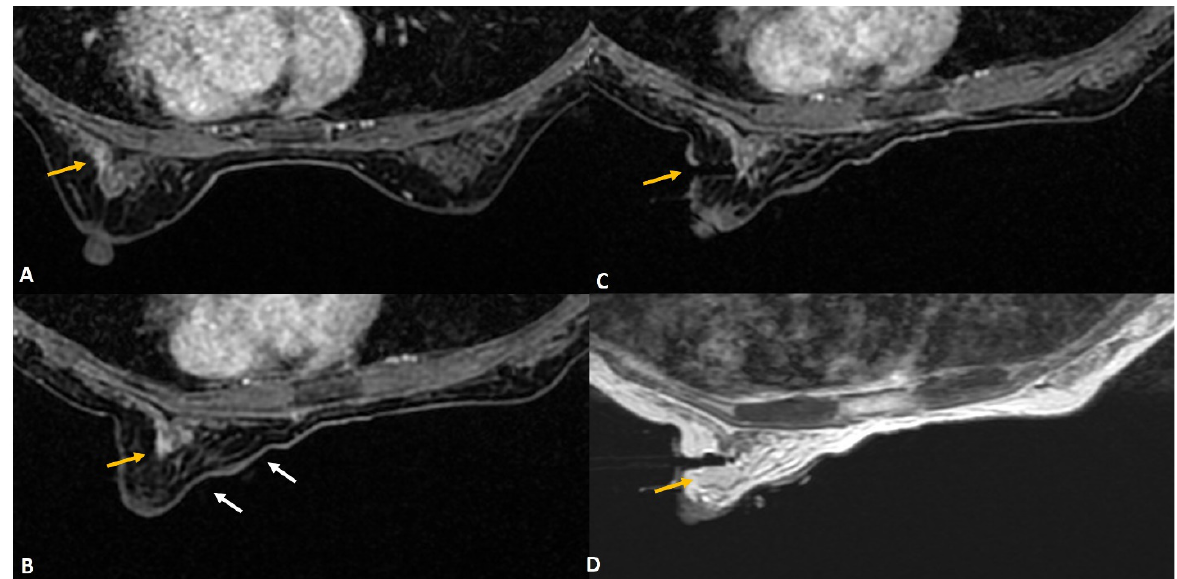
Figure 3. ( A ). MRI was performed in a woman with architectural distortion on mammogram de- tected during screening without sonographic correlate. A small enhancing correlate was identified on MRI (yellow arrow). ( B ). The breast size was extremely small. After removing the padding from the breast coil, the patient was tilted to obtain the target site in the grid hole. Additional padding was applied on the medial aspect (white arrows) to obtain optimal breast thickness making the procedure feasible and the target lesion (yellow arrow) accessible. ( C ). Tip of the obturator was noted at the target site (yellow arrow) and biopsy was performed using blunt tip Petit needle. ( D ). Post-biopsy hematoma (yellow arrow) is noted with adequate sampling. Histology was reported as radial scar.